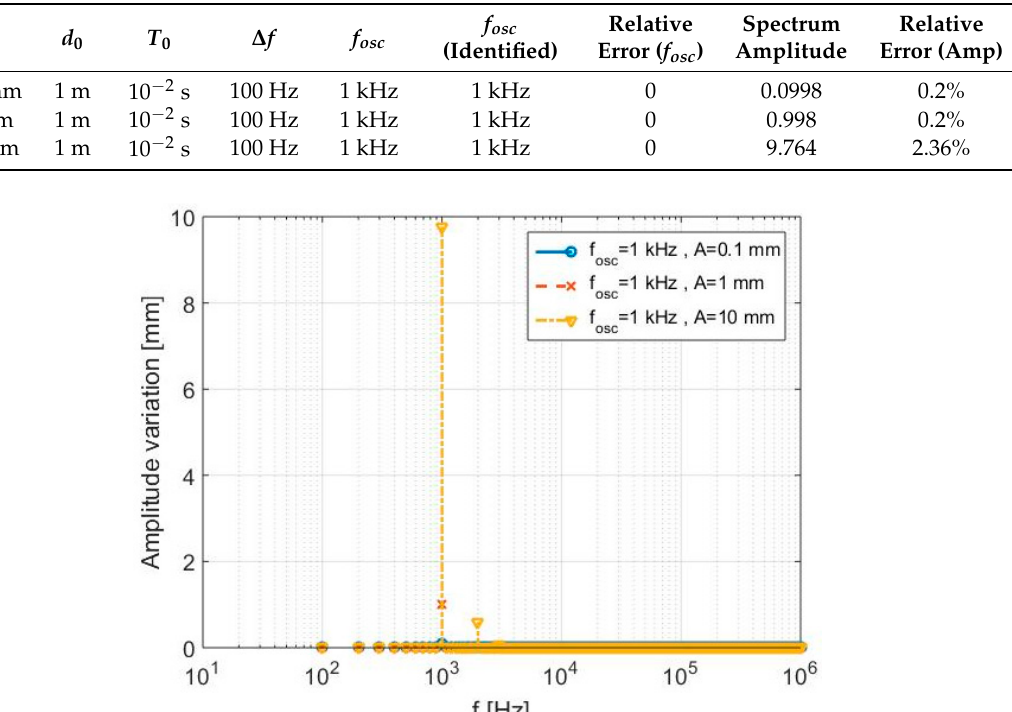
Figure 5. Second simulation—Detected displacement spectra.